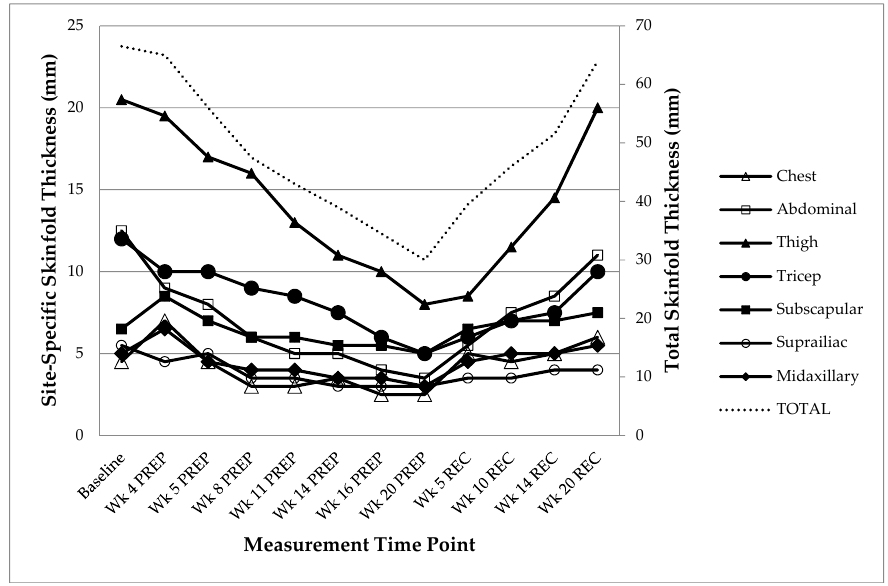
Figure 3. Total and Site-Specific Skinfold Thickness Changes. Wk: Week; PREP: Competition Preparation; REC: Competition recovery.